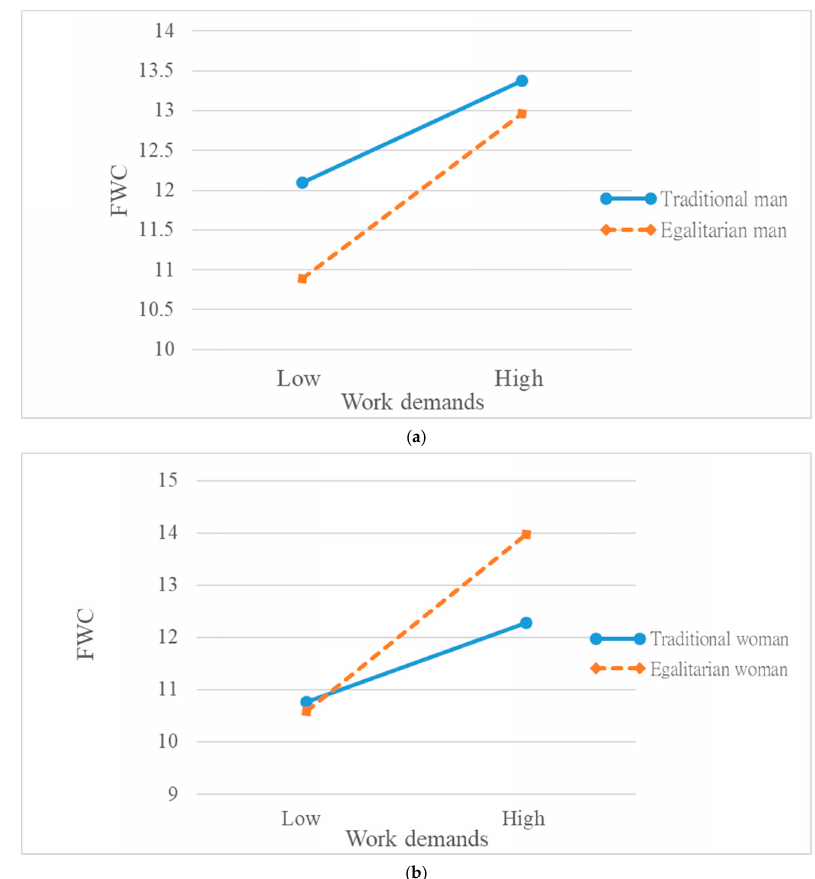
Figure 1. ( a ). Interactive effect of gender role orientation and work demands on family-to-work conflict (for men). ( b ) Interactive effect of gender role orientation and work demands on family-to-work conflict (for women). The same logic and procedure described above was followed when testing for H2 (family demands for women). The results are reported in Table 4.